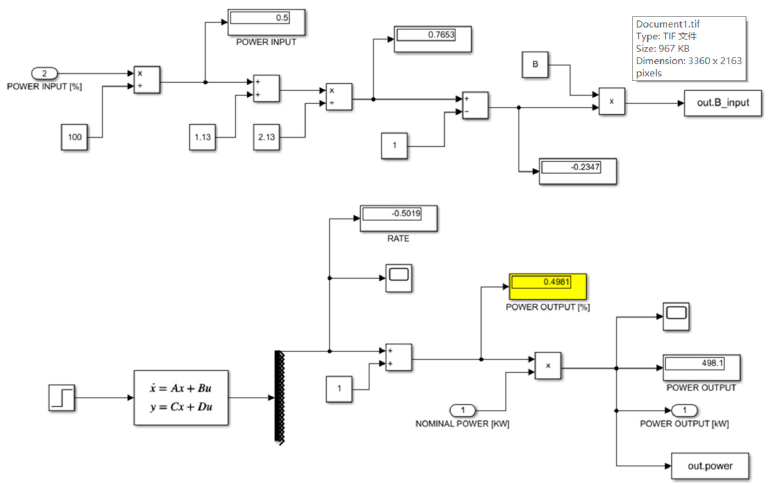
Figure 13. Simulink schematic.